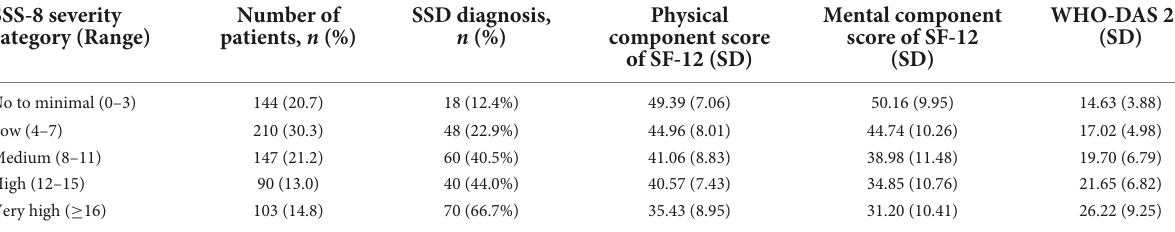
Number of patients, n (%)